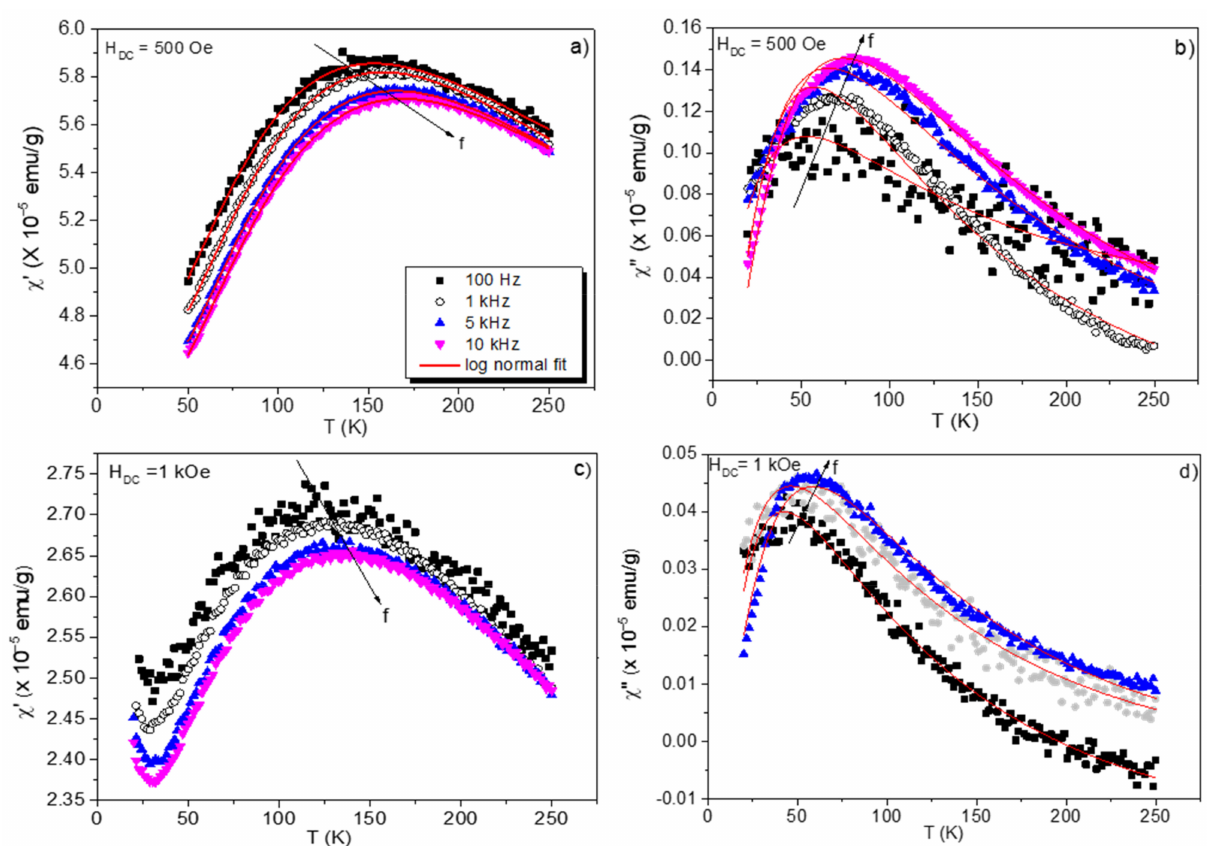
Figure 3. Selected AC magnetic susceptibilities ( χ (cid:48) (T,f) ( a )–( c ) and χ ”(T,f) ( b )–( d )) recorded under two DC bias fields (0.5 and 1 kOe) and for different frequencies. The full lines correspond to the fittings of the data using log-normal